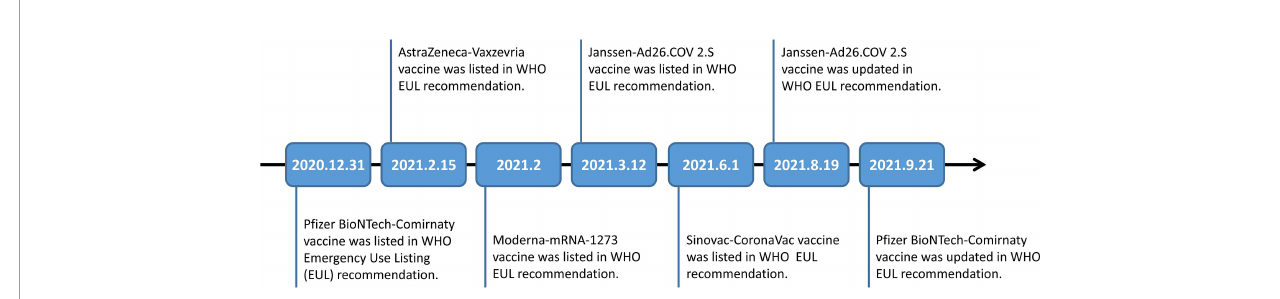
FIGURE 2 | Timeline of P fi zer BioNTech-Comirnaty vaccine, AstraZeneca-Vaxzevria vaccine, Moderna-mRNA-1273 vaccine, Janssen-Ad26.COV 2.S vaccine and Sinovac-CoronaVac vaccine listed in WHO EUL